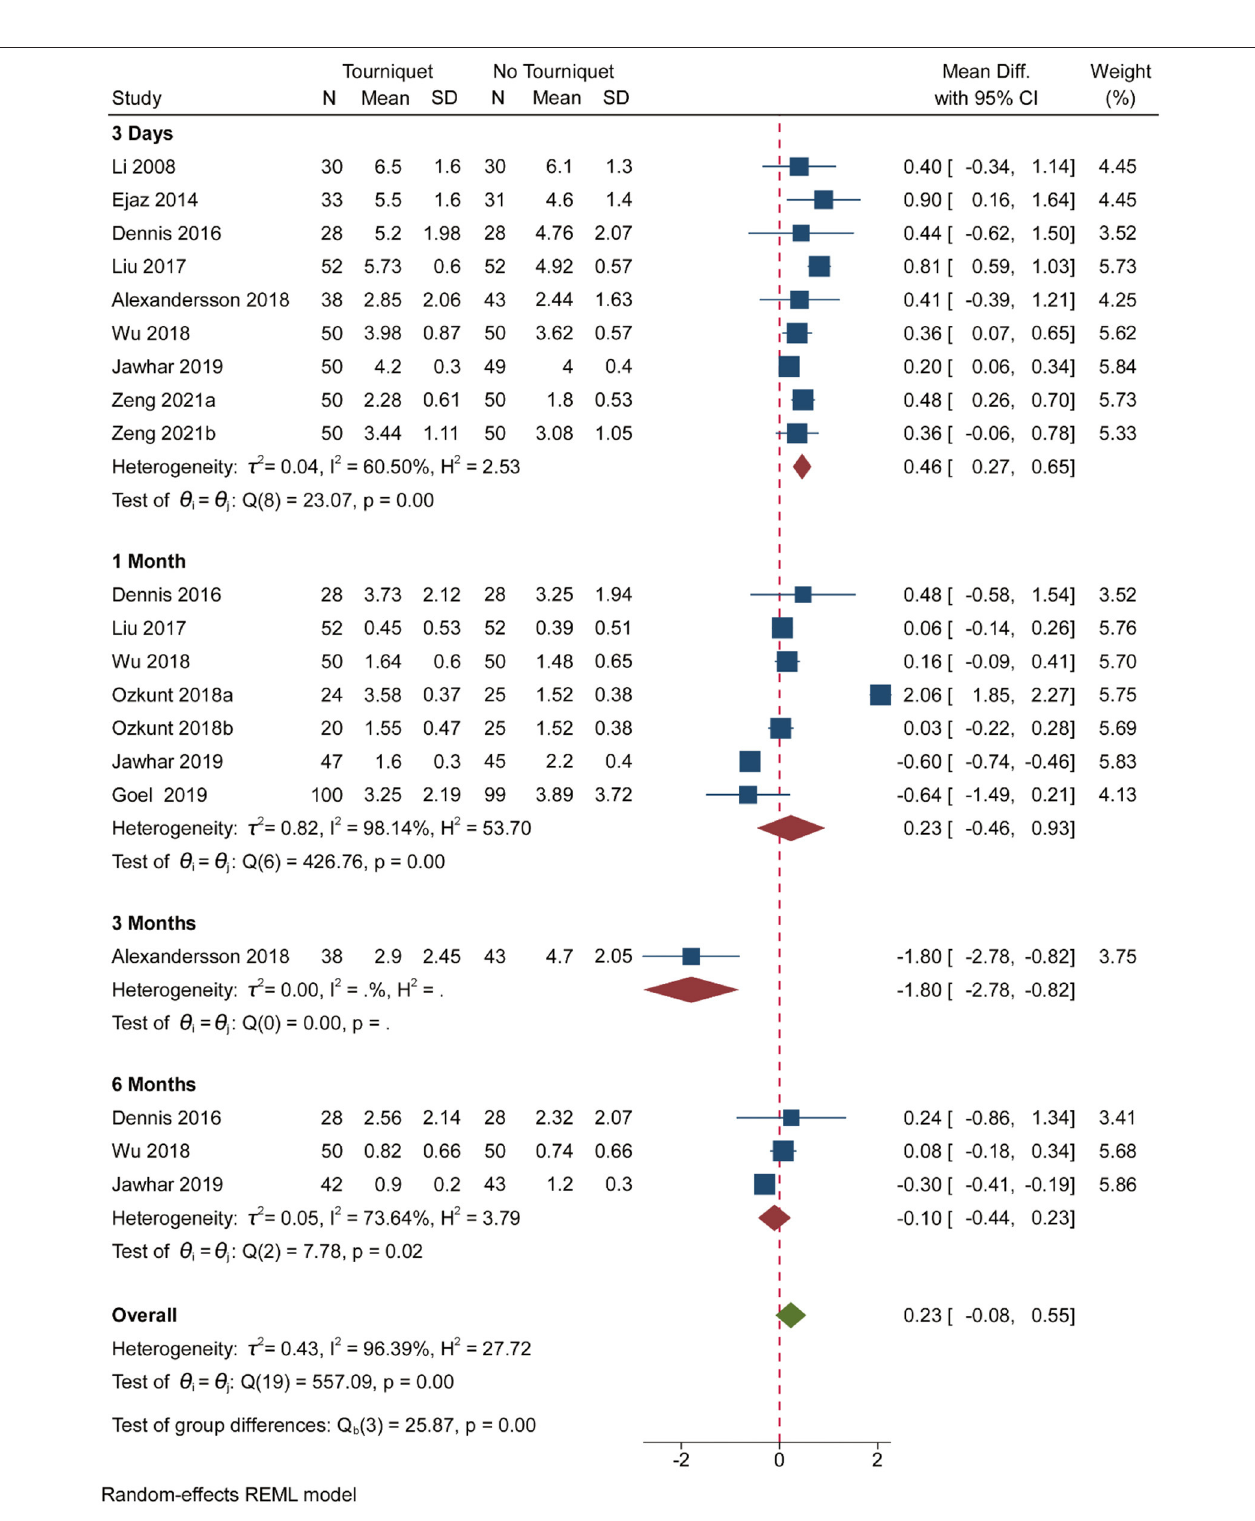
FIGURE 2 | Forest plot comparing pain outcomes in no tourniquet and tourniquet groups.